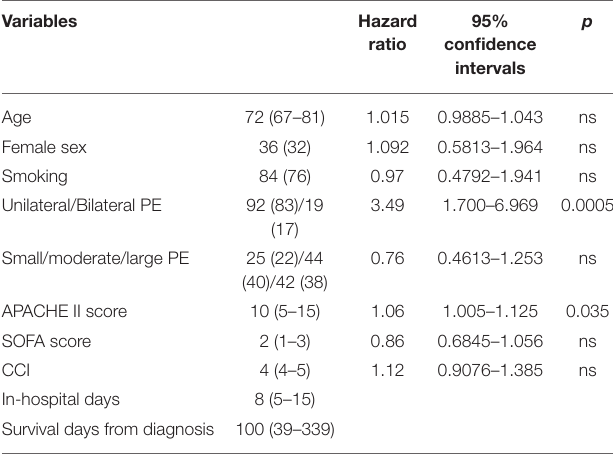
TABLE 7 | Prognostic characteristics of survival in subjects with Malignant pleural